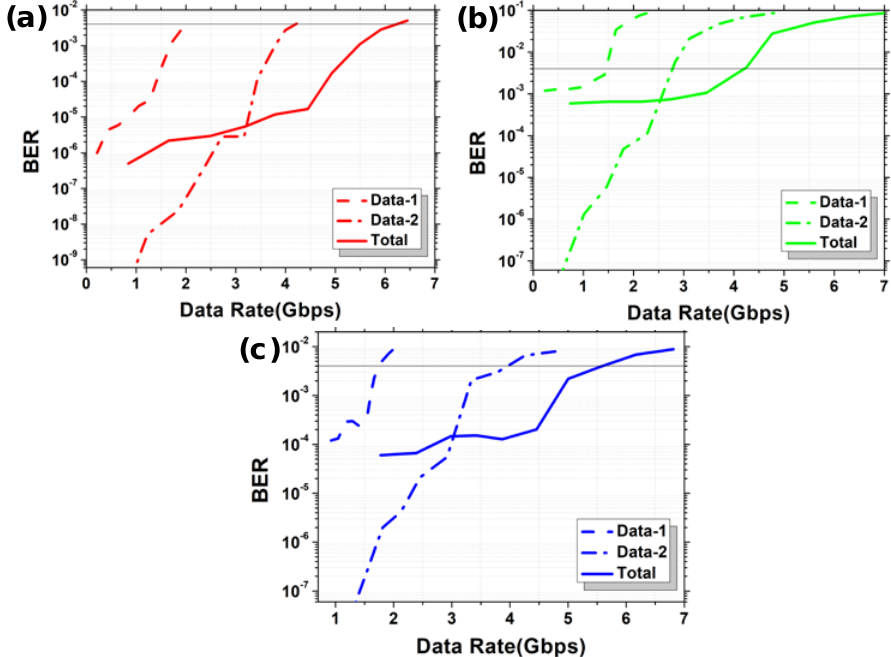
Figure 9. Experimental BER curves of the Data 1, Data 2, and the combined OFDM-NOMA signals for the ( a ) R, ( b ) G, and ( c ) B channels in BPSK format.